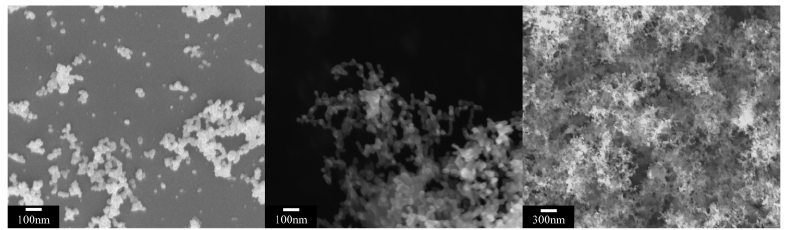
Figure 2. SEM images of nanoaggregate structure.